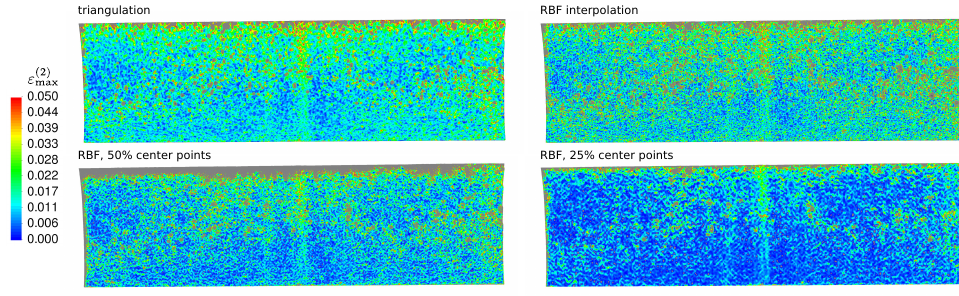
( 2 ) Figure 15. Principal maximum strain behavior ε max of smoothing data for tension of smooth surface sample, see Figure 13 (right) using the linear least-square approach (27). ( top left ) Classical triangula- tion concept, ( top right ) IMQ + Mon, i.e., center points equal data points, ( bottom left ) IMQ + Mon + LLS 50% center points, ( bottom right ) IMQ + Mon + LLS 25% center